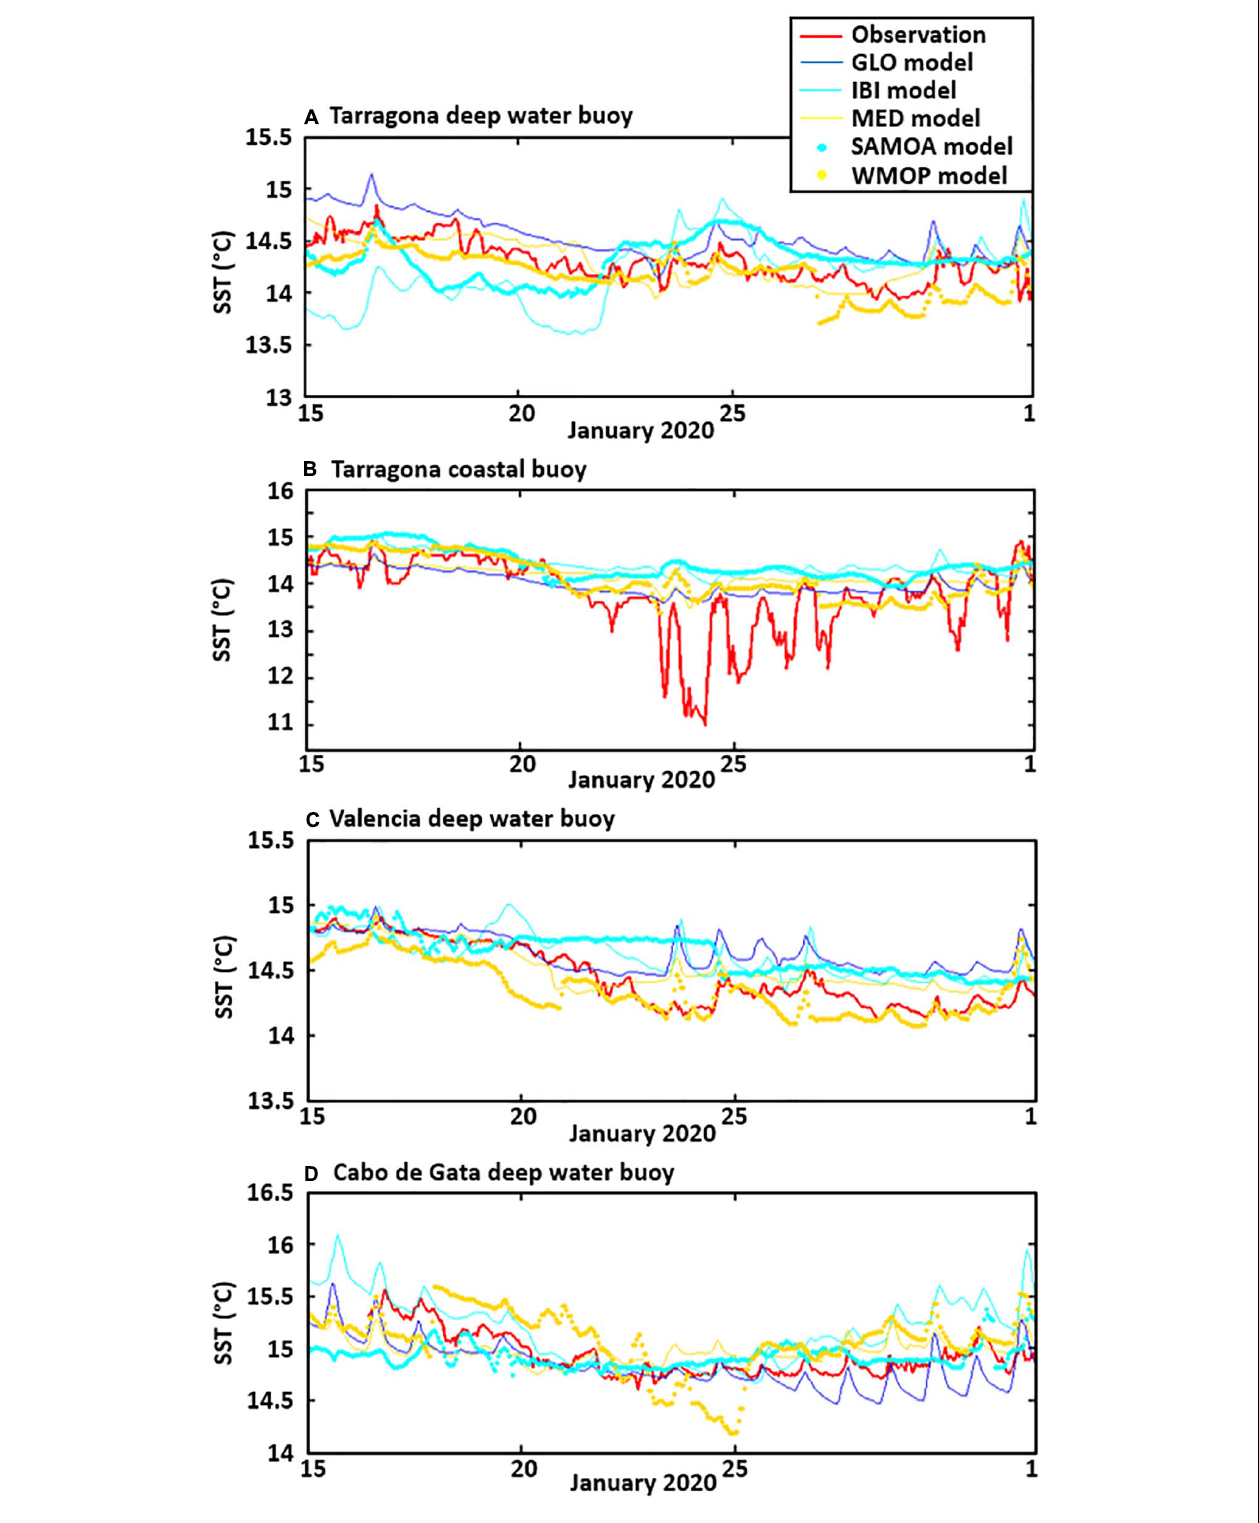
FIGURE 7 | Validation of operational ocean models with in situ observations buoys: Timeseries of sea surface temperature ( ◦ C) at the Tarragona (A) , Valencia (C) , and Cabo de Gata (D) deep water buoys, and at the Tarragona coastal buoy (B) . Observed and simulated (by the five model services: CMEMS GLO, IBI, MED, and the SOCIB WMOP and PdE SAMOA) timeseries